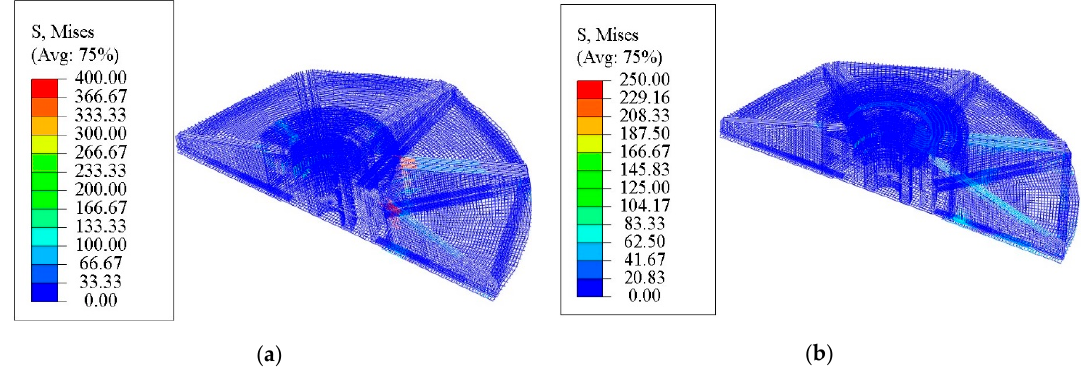
Figure 10. Von Mises stress of steel bar before and after strengthening under the extreme load case. ( a ) Von Mises stress of steel bar before strengthening (MPa); ( b ) Von Mises stress of steel bar after strengthening (MPa).